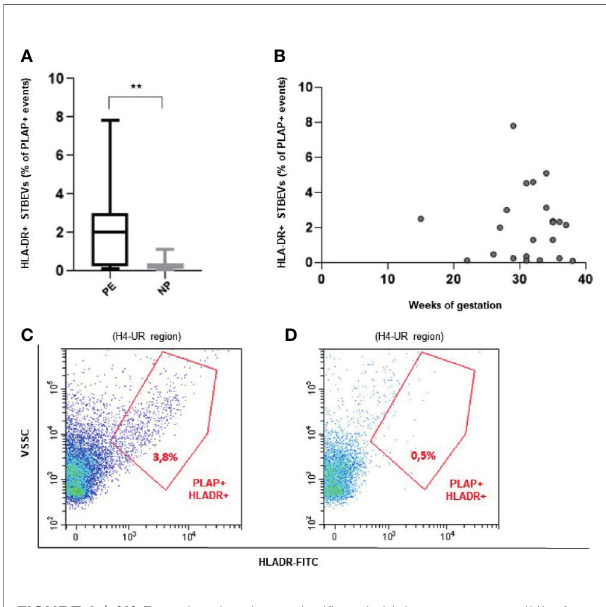
FIGURE 2 | (A) Box plot showing a signi fi cantly higher percentage (%) of HLA-DR positive (+) STBEVs (PLAP positive events) detected in plasma of PE versus NP women. (B) Scatter plot showing distribution of HLA-DR positive (+) STBEVs detected in PE according to gestational age. (C, D) Representative fl ow cytometric analysis for PLAP and HLA-DR double positive (+) vesicles collected from plasma of a PE (C) and a NP (D) woman. NP, normal pregnant women; PE, pre-eclamptic women; PLAP, placental alkaline phosphatase; STBEVs, syncytiotrophoblast-derived extracellular vesicles. **p <